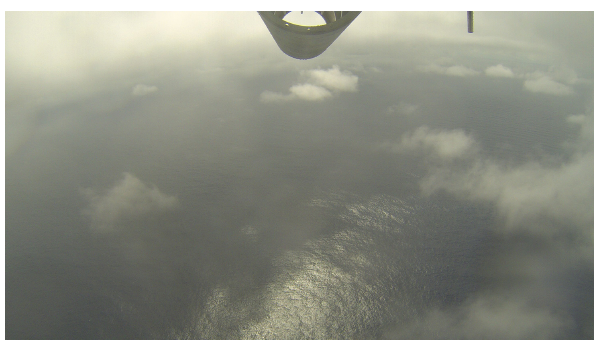
Figure 22. Cumulus clouds under stratocumulus in the decoupled STBL. Photograph was taken during PROF5 of flight no. 14 by the camera mounted on the bottom of